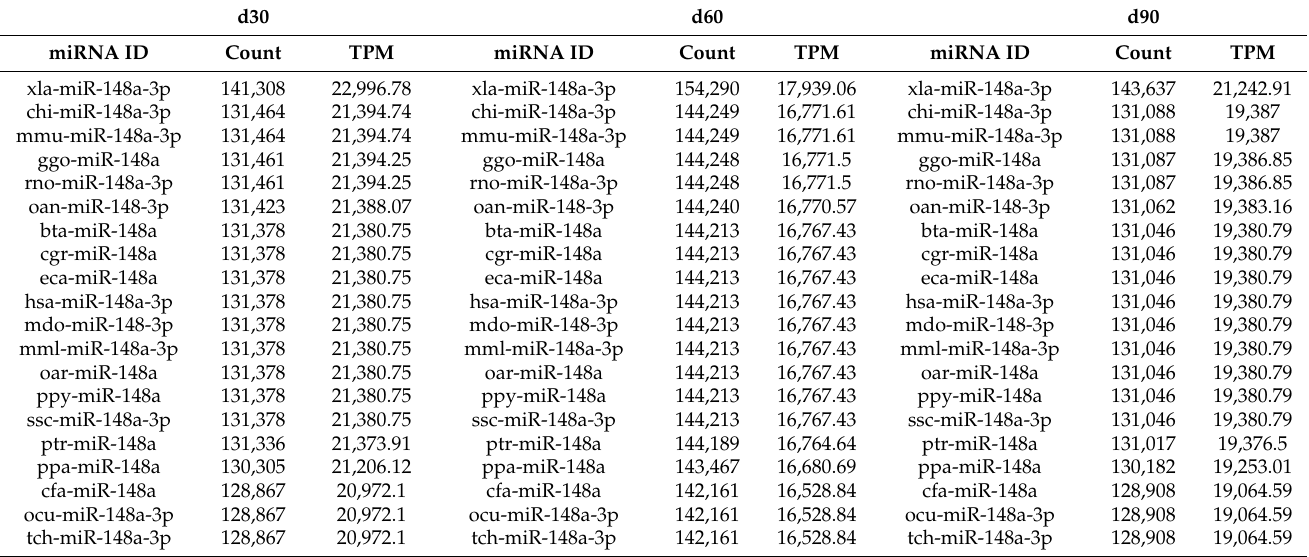
Table 2. The top 20 known miRNAs with the highest expression abundance in antler growth centers at different growth stages.